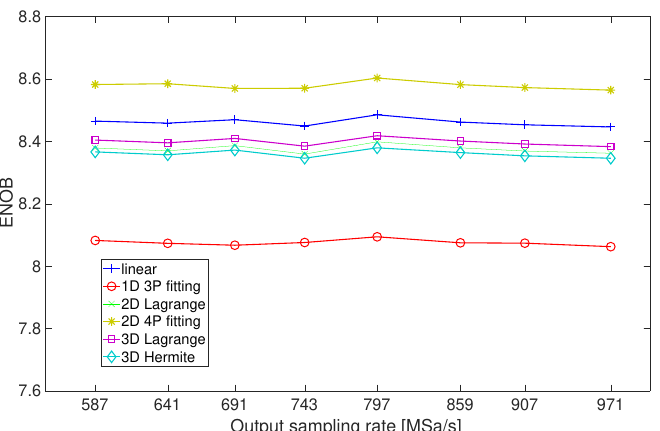
Figure 5. ENOB offered by the resampling approaches in the presence of an input sine-wave at 20 MHz when the 1 GHz input sampling rate is lowered down to frequencies of the set { 587,641,743,797,859,907,971 }